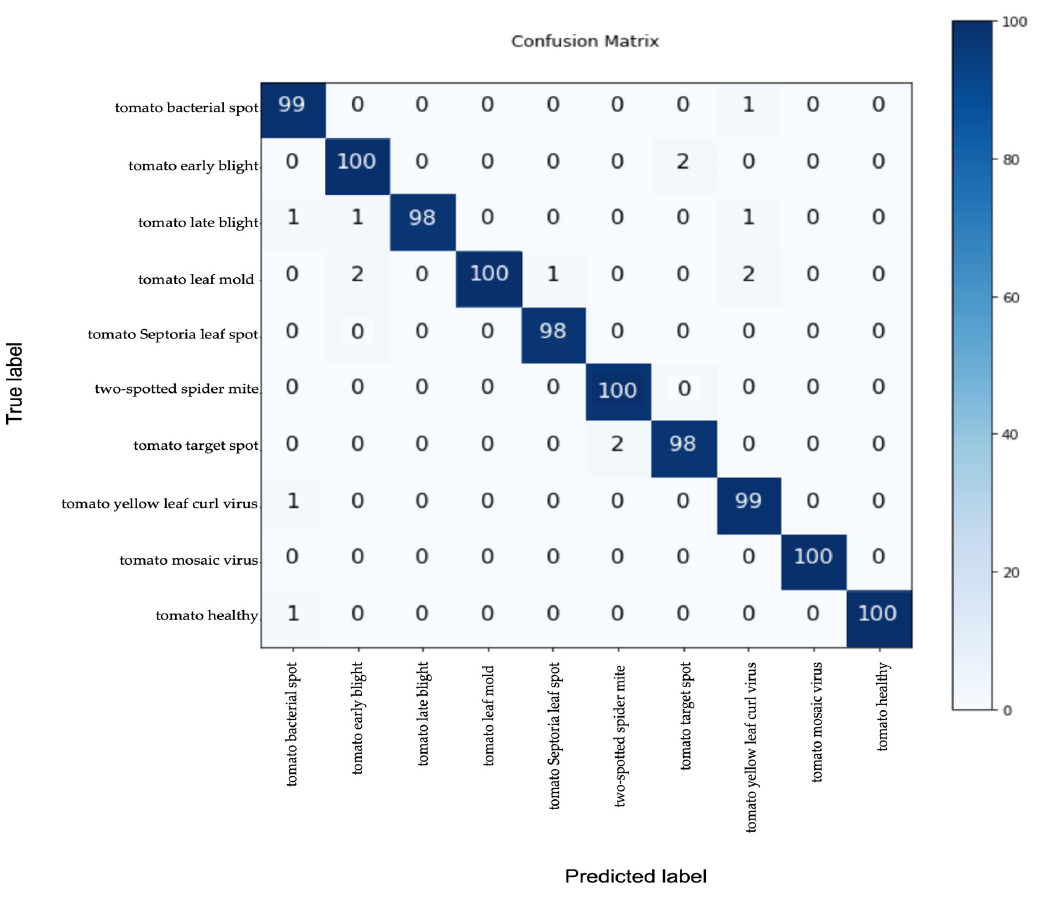
Figure 6. Confusion matrix of the proposed model.